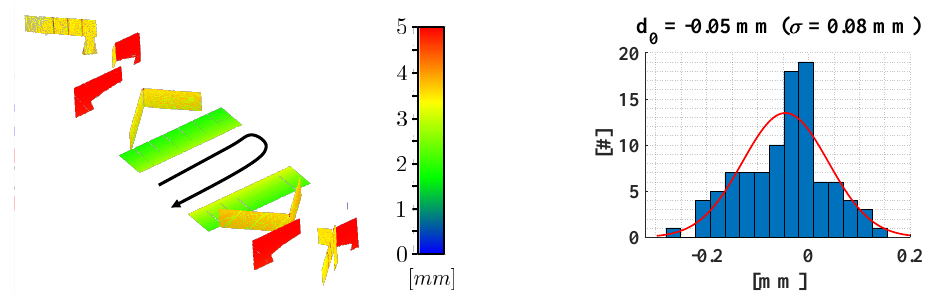
Figure 12. ( Left ) Sensitivity of the plane setup towards a range finder offset. The colored plot shows the point-to-plane distance in the case of an unmodelled range finder offset of d 0 = 5 mm. ( Right ) Distribution of the estimated range finder offsets for the 98 calibration runs. The mean value is − 0.05 mm and the empirical standard deviation is 0.08 mm. For comparison, an ideal Gaussian distribution is